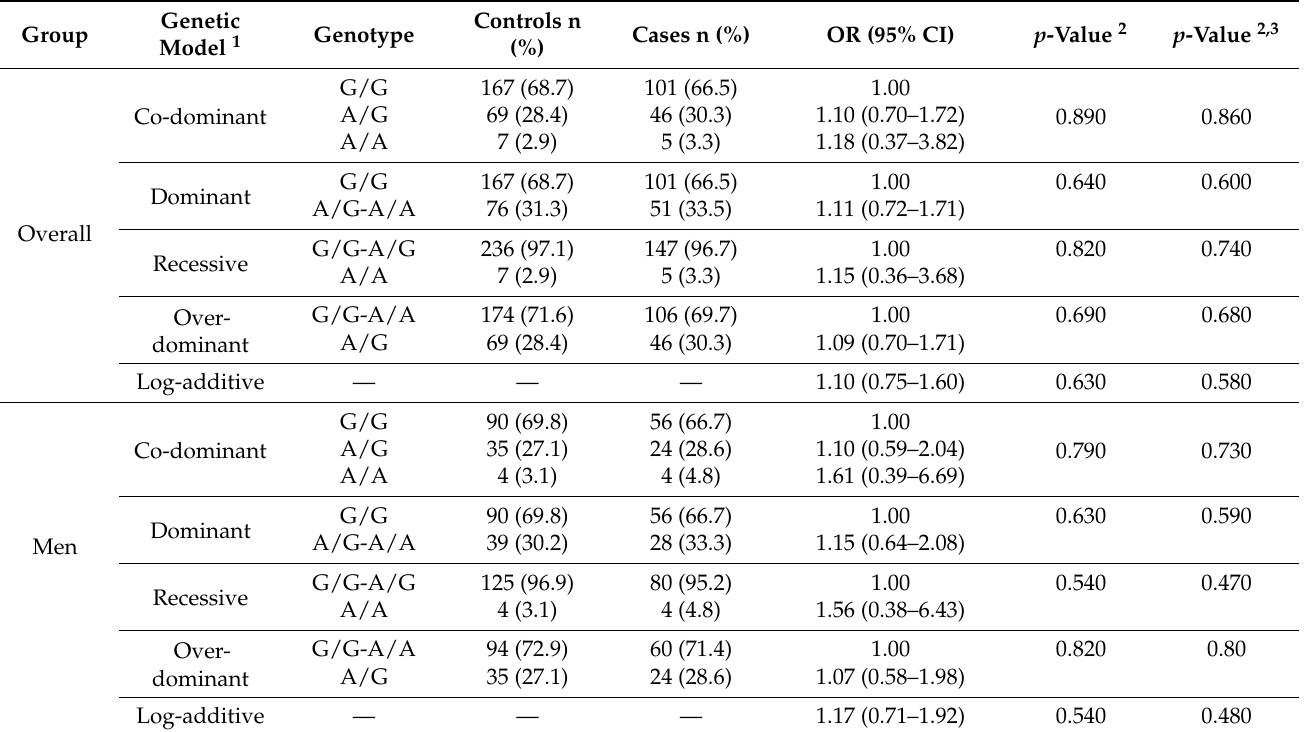
Table 4. Association analysis of rs61275591 polymorphism near ANKRD55 – MAP3K1 genes with primary open-angle